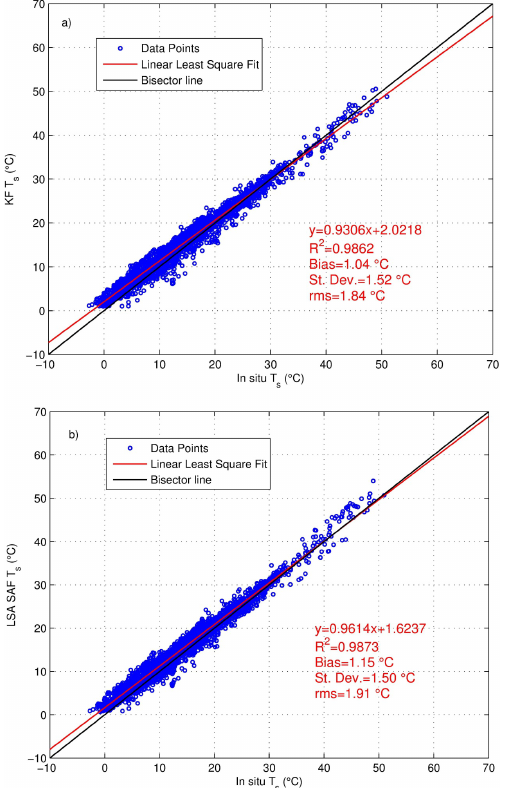
Figure 5. Evora station. Scatter plot of SEVIRI surface tempera- ture retrieval and in situ observations at Evora for 2010 (a) KF (this study retrieval) and (b) LSA SAF retrieval. Note: R 2 is the linear correlation coefficient.